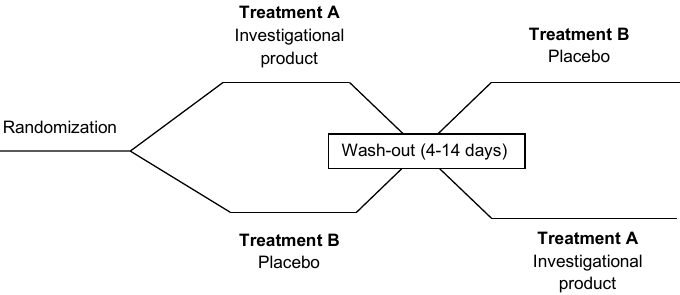
Figure 1. Double-blind, randomized, placebo-controlled, cross-over study design.